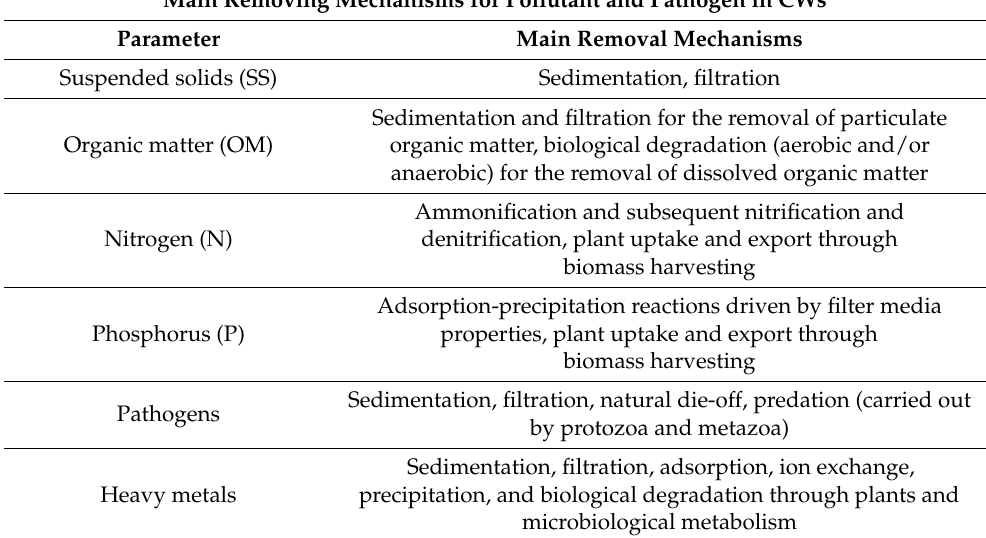
Table 1. Treatment Mechanisms